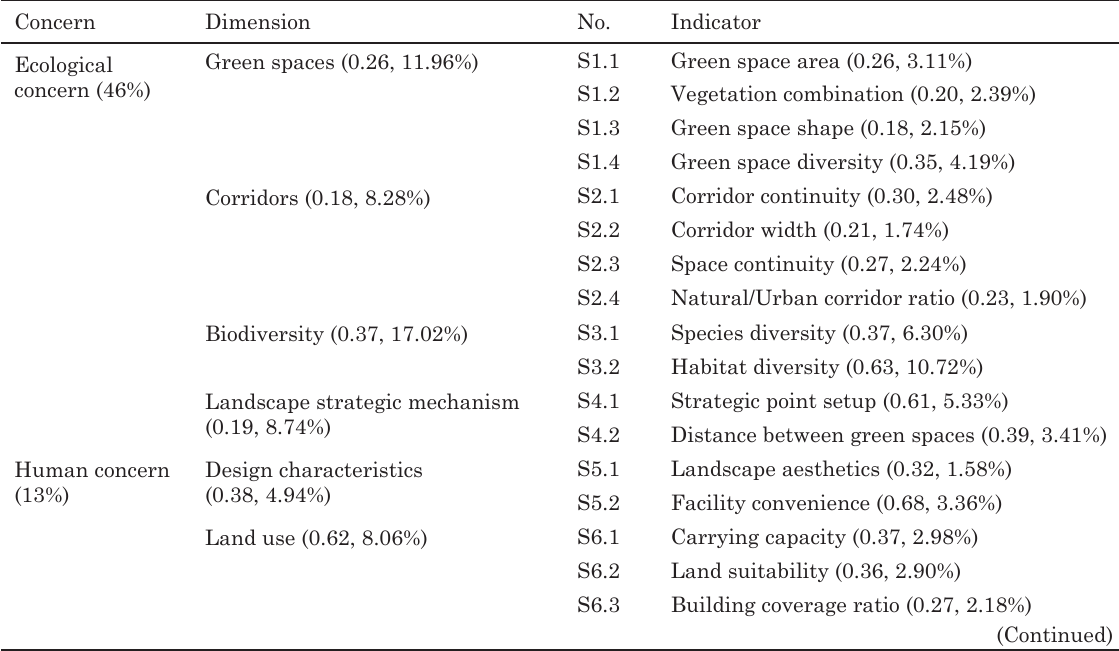
table 5. Key ecological indicators for urban land consolidation